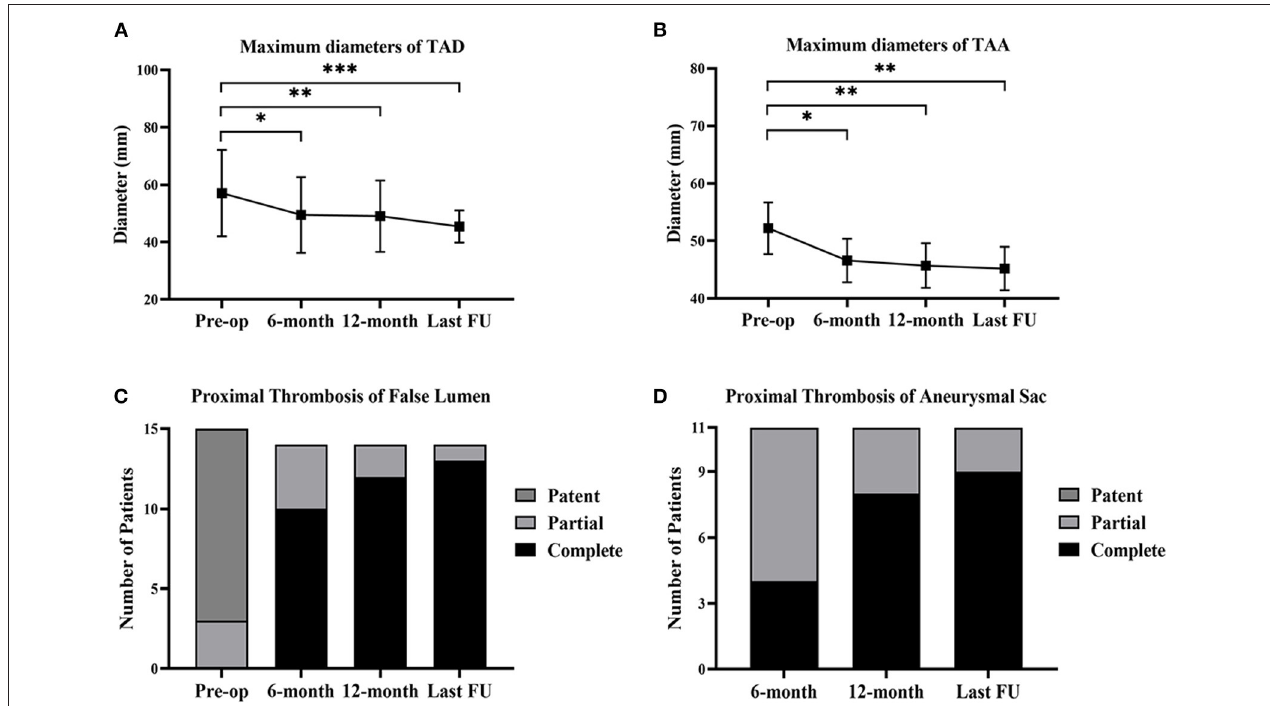
FIGURE 6 | Aortic remodeling and proximal thrombosis of false lumen/aneurysmal sac at follow-up. (A) The changes of maximum diameters of TAD before the operation, at 6-month, 12-month, and the last follow-up. (B) The changes of maximum diameters of TAA before the operation, at 6-month, 12-month, and the last follow-up. (C) The proximal thrombosis of false lumen in TAD ( n = 15) before the operation, at 6-month, 12-month, and the last follow-up. One patient suffered from retrograde type A aortic dissection after 3 months and received the total arch replacement. (D) The proximal thrombosis of aneurysmal sac in TAA ( n = 11) at 6-month, 12-month, and the last follow-up. * p < 0.05; ** p < 0.01; *** p < 0.001. TAD, thoracic aortic dissection; TAA, thoracic aortic aneurysm; FU,